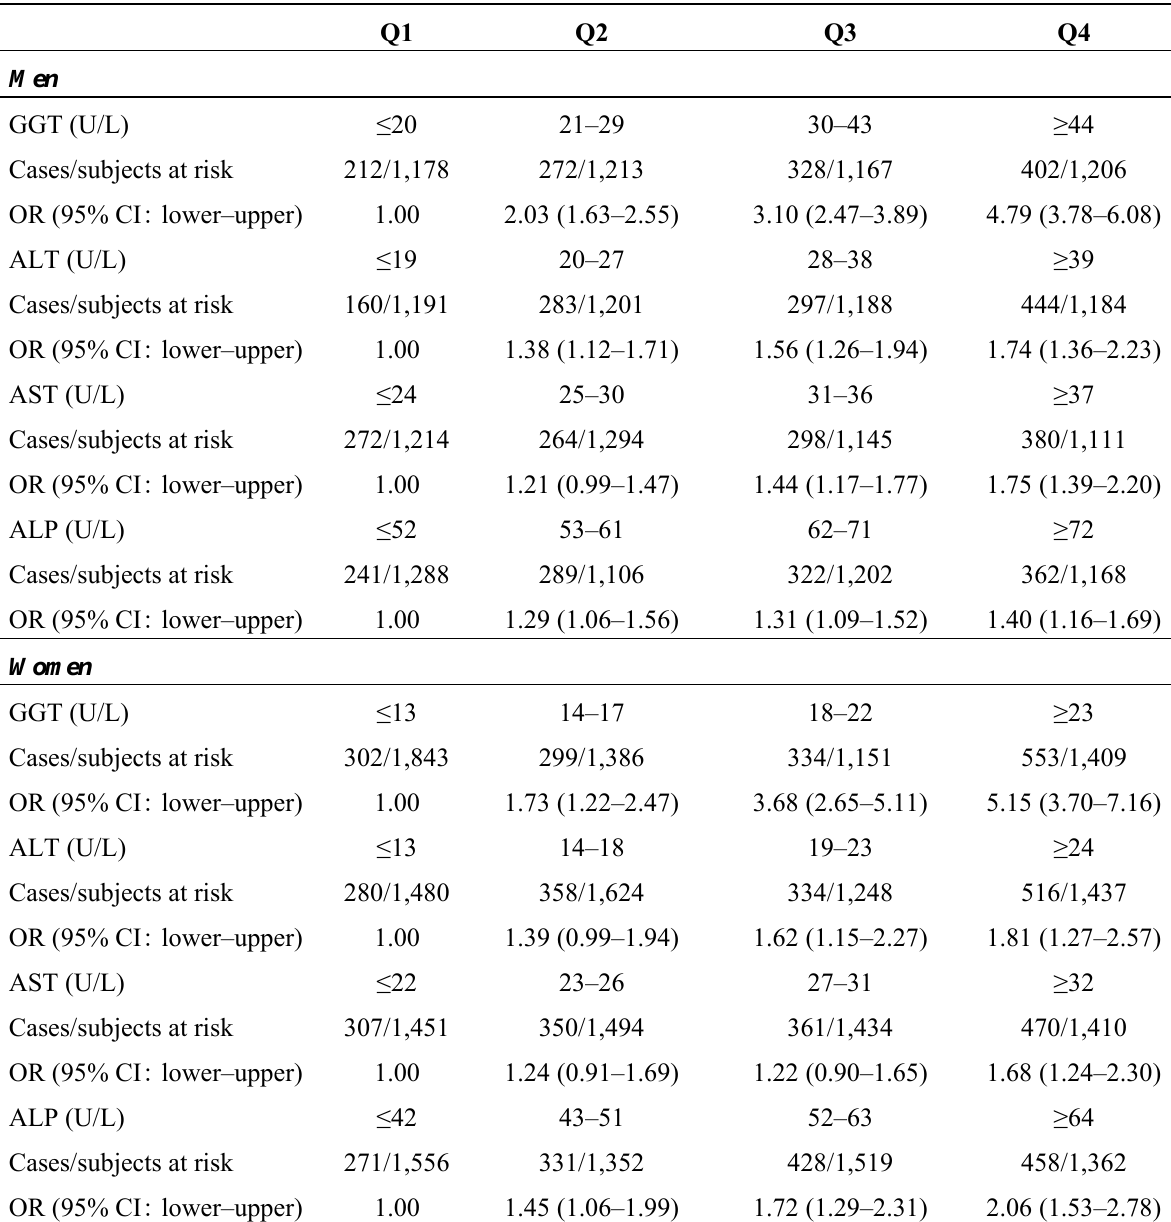
Table 5. Factors associated with elevated TG by